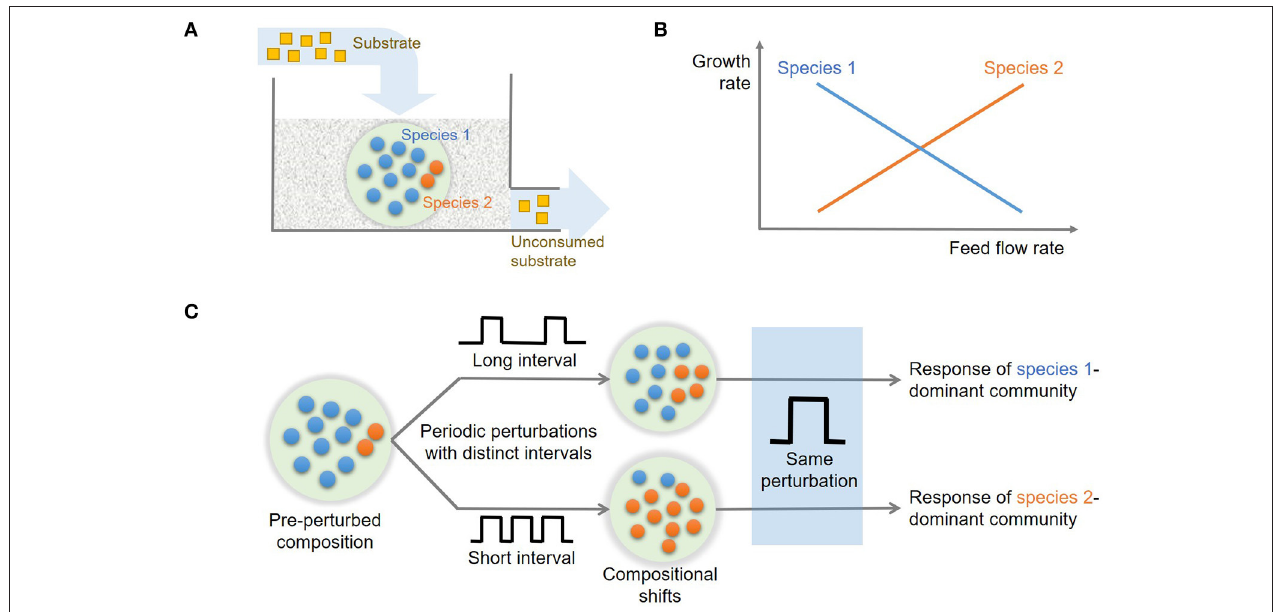
FIGURE 1 | Conceptual model to investigate historical contingencies in microbial response to hydrologic perturbations: (A) a continuous flow reactor configuration for competitive growth of two microbial species on a shared substrate in a homogeneous environment, (B) trade-offs in microbial growth along the flow rate gradient, and (C) expected compositional changes driven by the history of hydrologic perturbations.